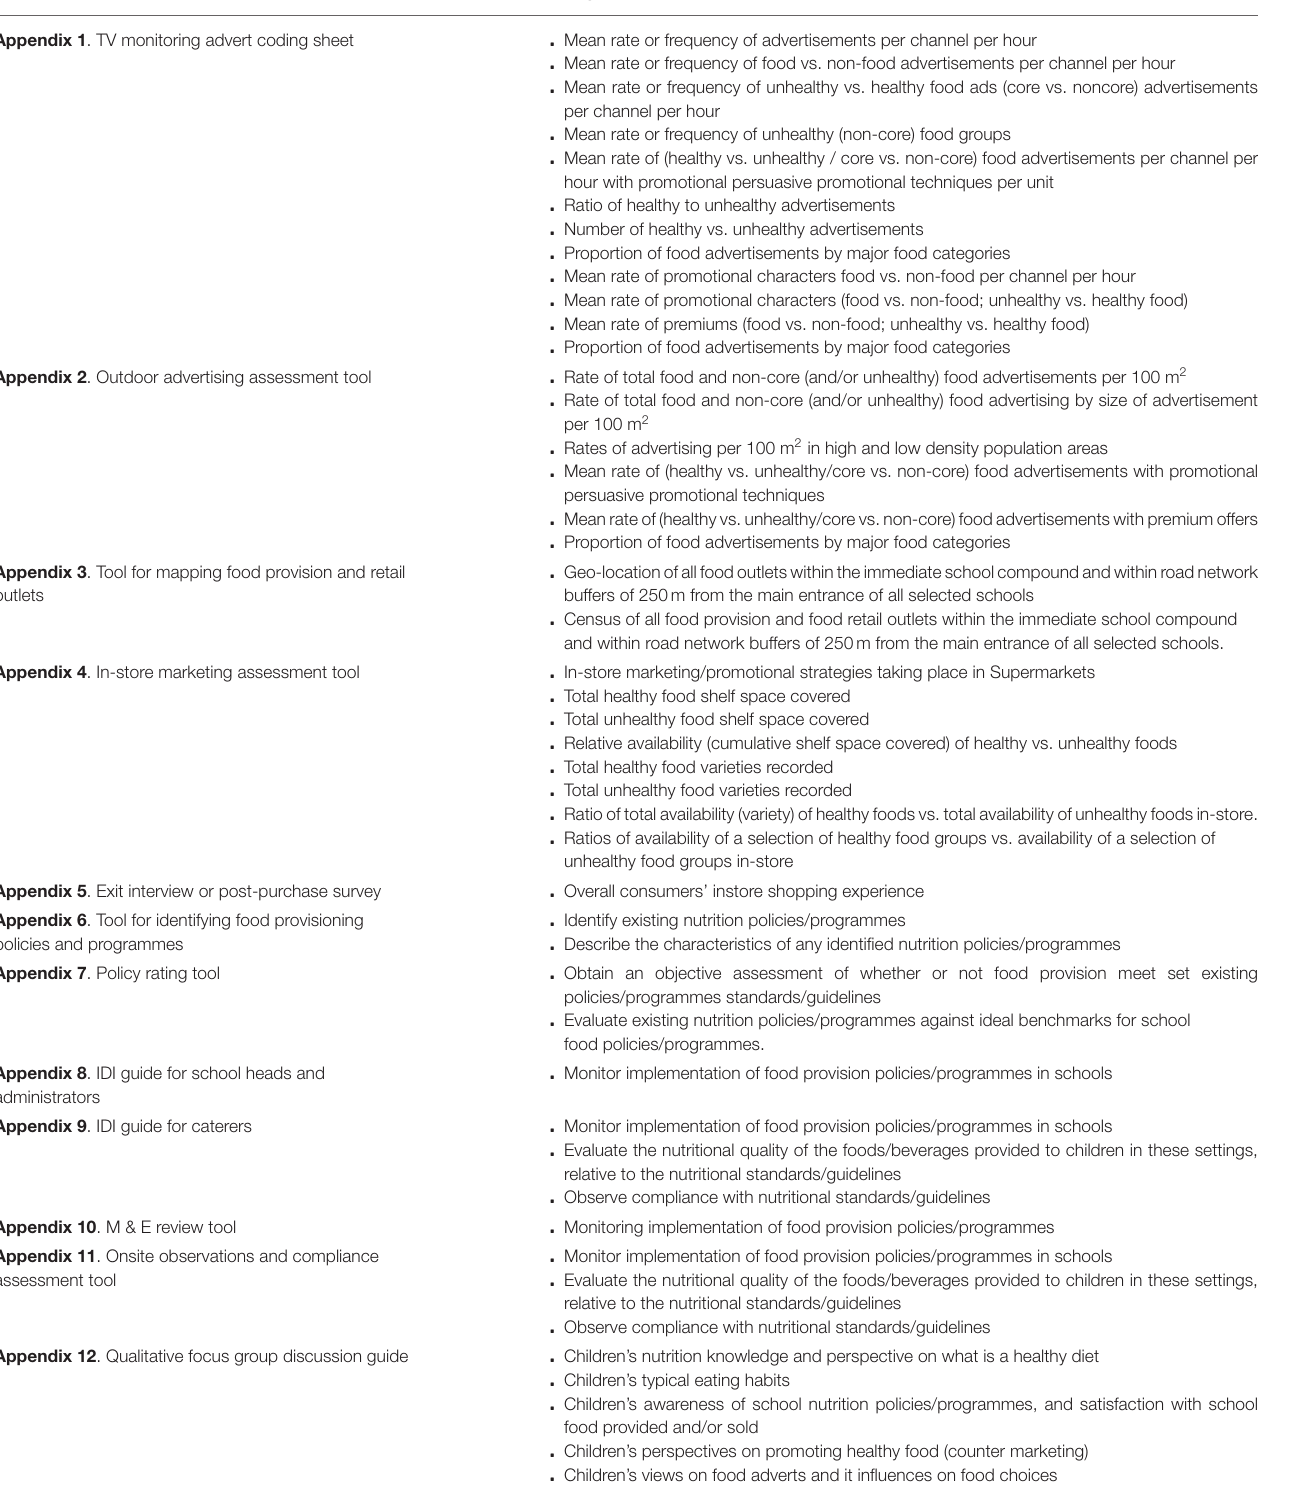
TABLE 1 | Study outcome indicators by tool. Data collection